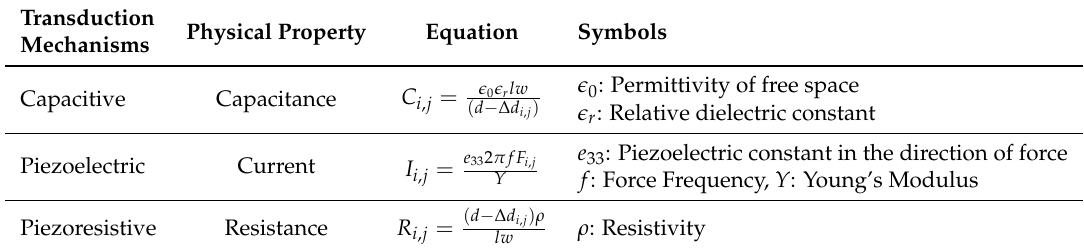
Table 3. Simulation Supported Physical